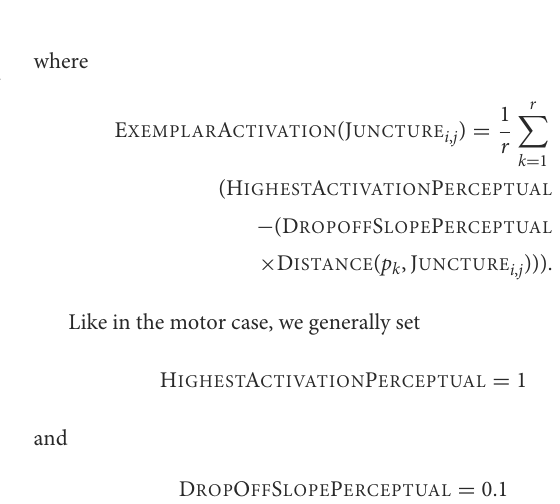
Where the motor activation of J UNCTURE i , j is defined to be the highest when J UNCTURE i , j is contained in SIL C ( t ) and to fall off linearly as the distance between J UNCTURE i , j and SIL C ( t ) increases, bottoming out at